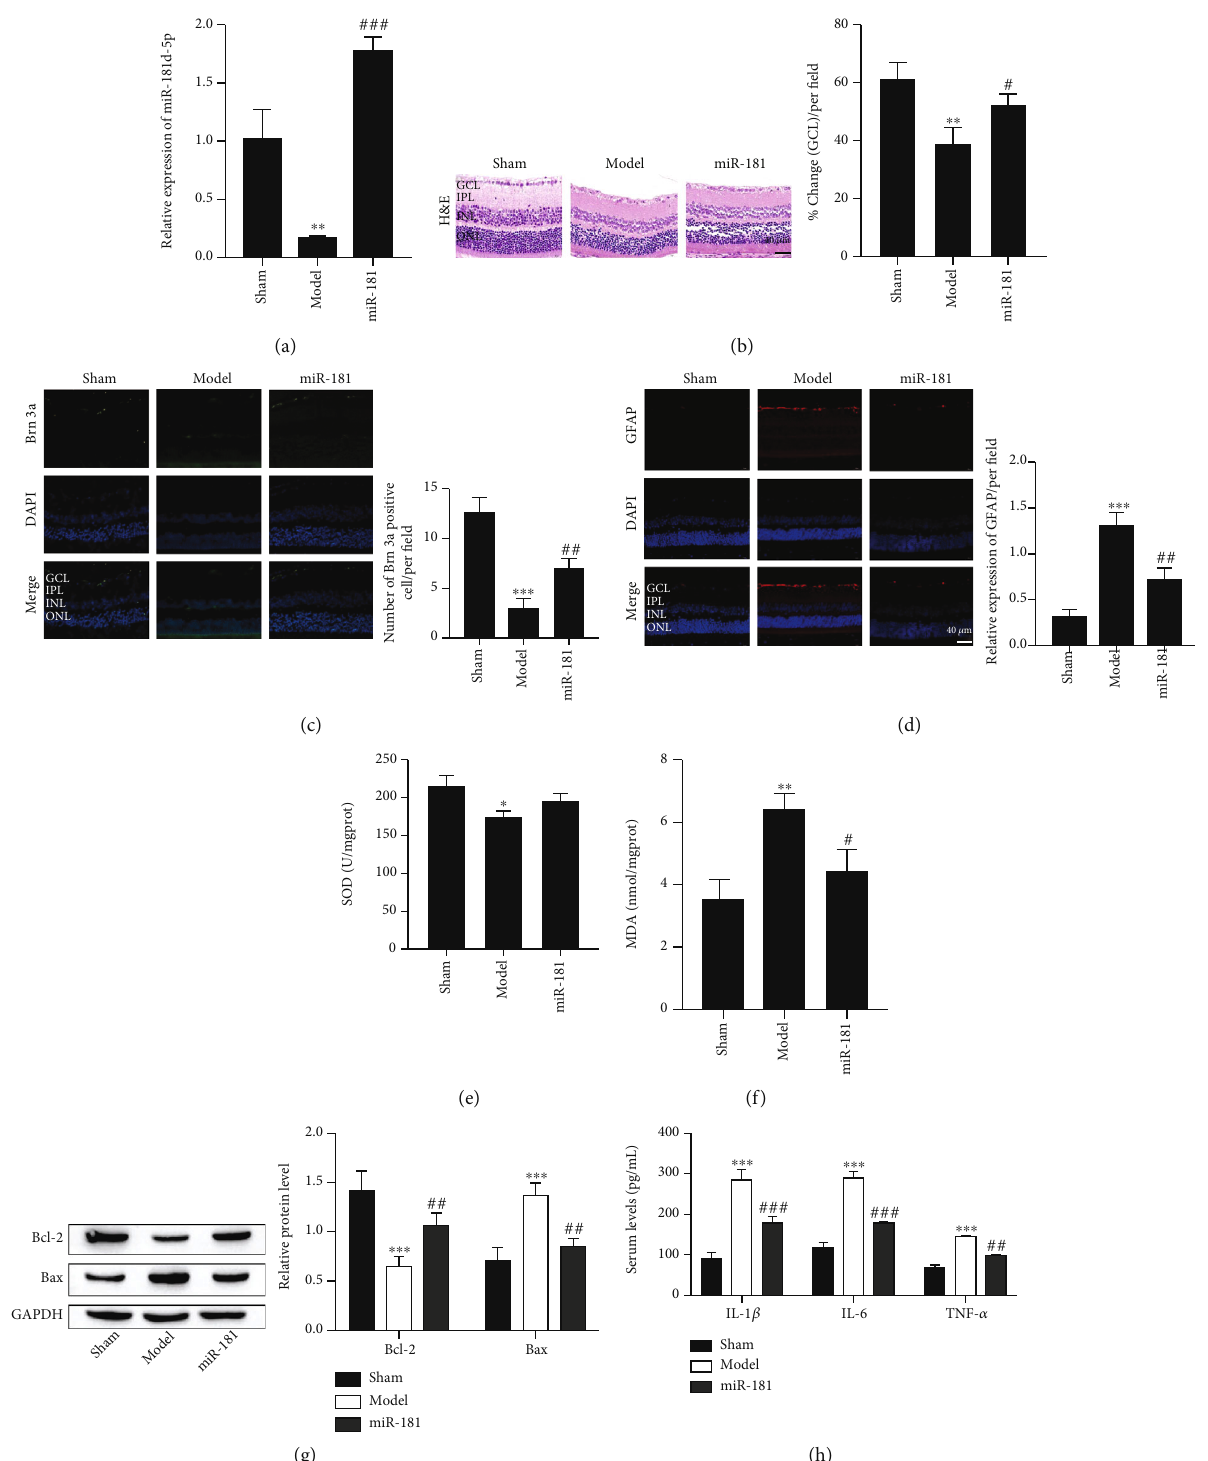
Figure 3: miR-181d-5p relieves RGCs death, astrocyte development, oxidative stress, and in fl ammation of the retina. (a) Expression of miR- 181d-5p by RT-qPCR detection. (b) Representative images of retinal tissues stained by H&E ( scale bar = 40 μ m). (c) Representative images of POU-homeodomain transcription factor Brn3a staining ( scalebar = 40 μ m). (d) GFAP staining ( scale bar = 40 μ m). (e) SOD activity. (f) MDA content. (g) Western blot assay of Bcl-2 and Bax protein. (h) Proin fl ammatory factor levels were measured by ELISA. ∗ P < 0 : 05 , ∗∗ P < 0 : 01 , and ∗∗∗ P < 0 : 001 vs. the sham group; # P < 0 : 05 , ## P < 0 : 01 , and ### P < 0 : 001 vs. the model